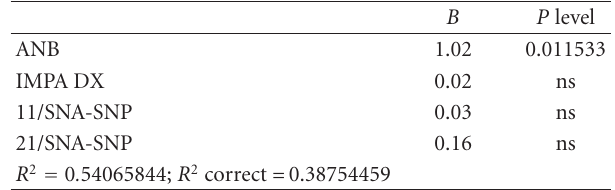
Table 4: Entire sample (42 subjects): linear regression results for Table 8: Group 2 (17 subjects): linear regression results OJ-l. OJ-l; only ANB and 21/SNA-SNP were found to be statistically ANB and 21/SNA-SNP were found to be statistically significant. significant. The systematic error calculated via Student’s t -test for The systematic error calculated via Student’s t -test for paired data paired data yielded a significance level of 0.05; ns: non significant yielded a significance level of 0.05; ns: non significant (Student’s t - (Student’s t -test). test). B